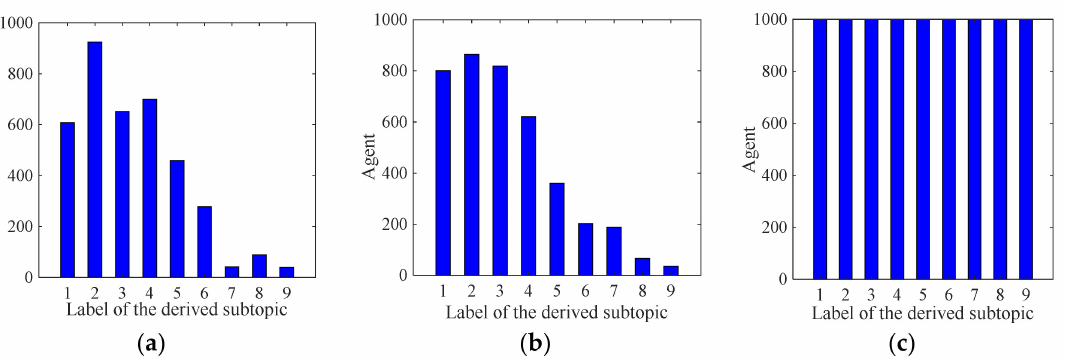
Figure 29. The number of agents participating in the discussion of derived subtopics under different network topologies. ( a ) WS small world network. ( b ) BA network. ( c ) Fully connected network.